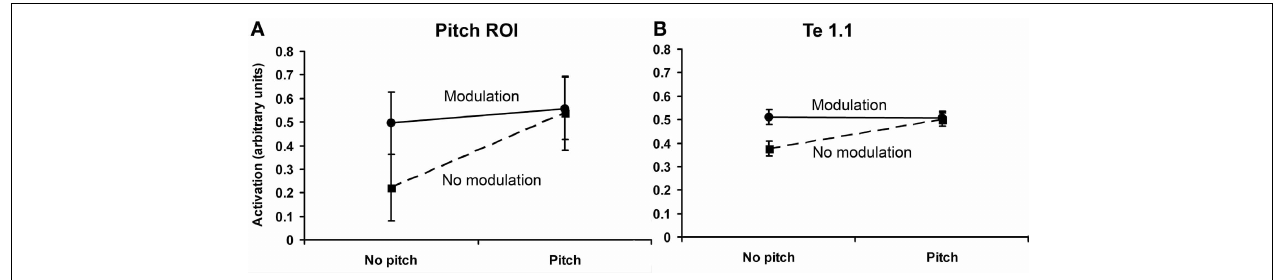
FIGURE 5 | Plot of the results of the 2 × 2 factorial design within the pitch-responsive ROI (A) and within medial HG (B). The ordinate measures percentage increase in BOLD activation from baseline. Error bars show standard errors.